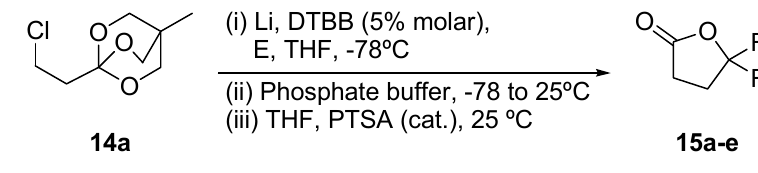
Table 3. Preparation of γ -lactones 15 from ortho ester